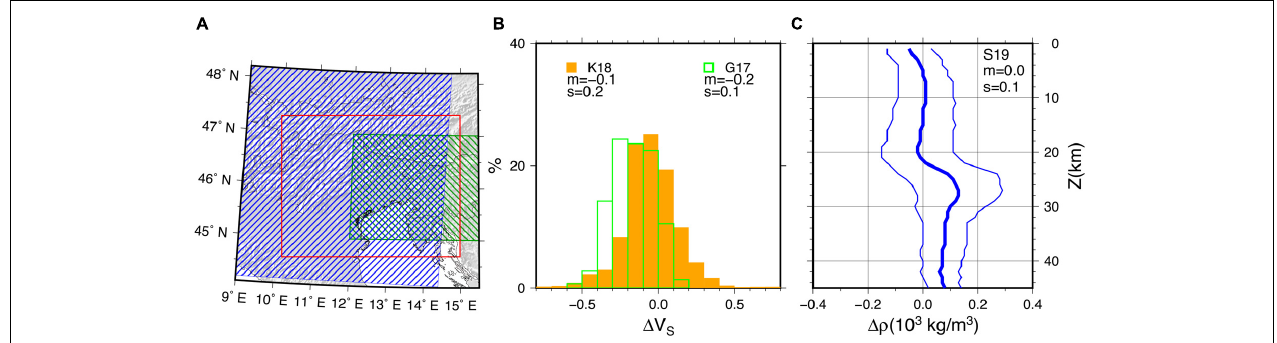
FIGURE 13 | Comparison of NAC V S and ρ with independent models. (A) Map with area covered by NAC (red line), Spooner et al. (2019) (S19 – area filled by blue lines) and Guidarelli et al. (2017) (G17 – area filled by green lines); the model of Kästle et al. (2018) covers the whole area (K18). (B) Histograms of the differences between the V S values of K18 and G17 and the V S values of NAC. (C) The differences between the ρ values of S19 and the ρ values of NAC at different depths (thick line: average of the differences; thin lines: average plus and minus a standard